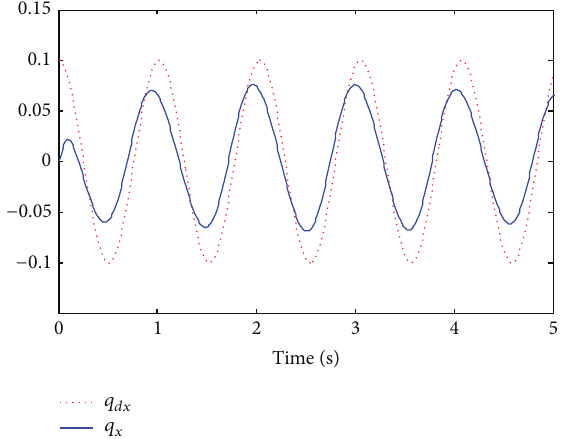
Figure 8: RBF network approximation of 𝑥 -axis component with adaptive neural sliding compensator.